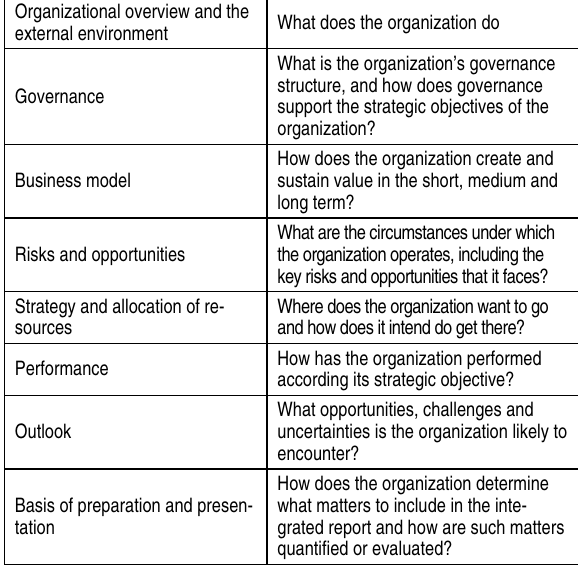
Table 2. The Framework’s content elements